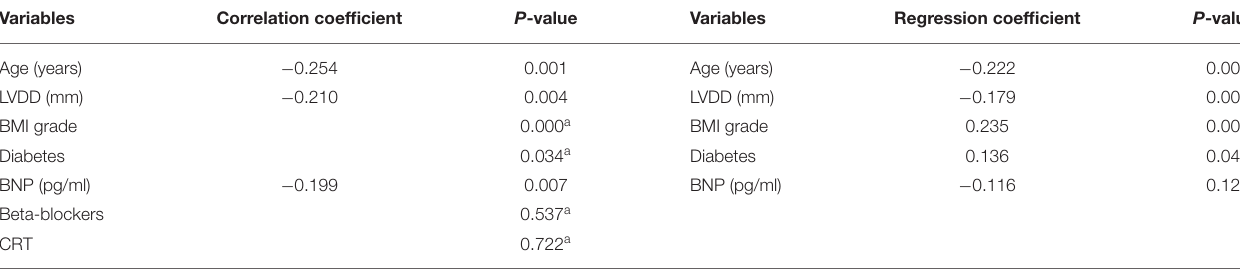
TABLE 2 | Factors associated with 6-month change in left-ventricular ejection fraction among